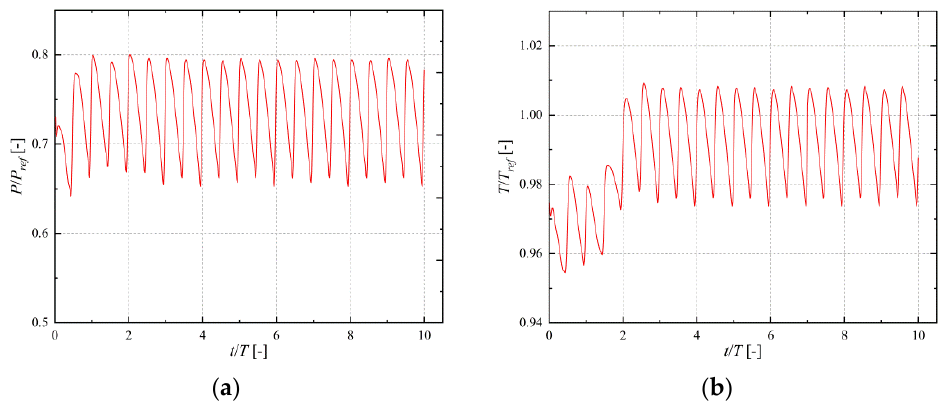
Figure 5. Normalized pressure and temperature ratio convergence history of the unsteady simulation. ( a ) Pressure ratio convergence history; ( b ) temperature ratio convergence history.